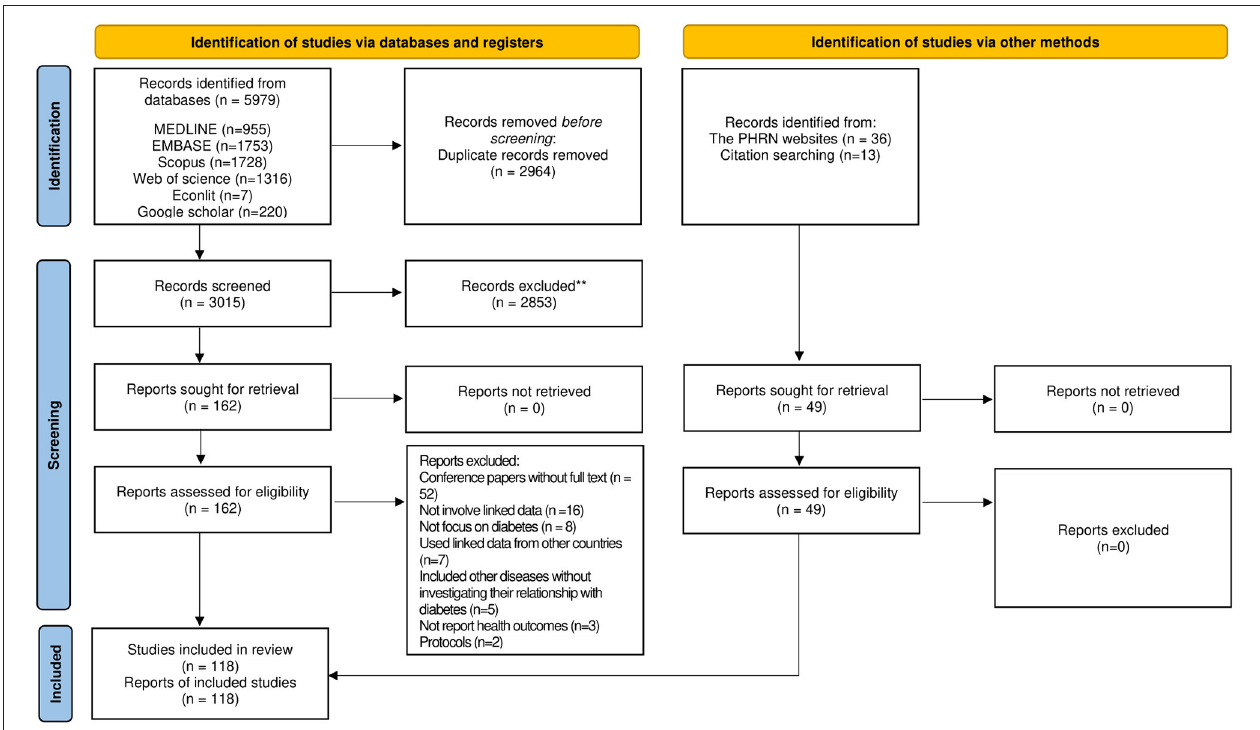
FIGURE 1 | PRISMA 2020 flow diagram for new systematic reviews which included searches of databases, registers and other sources. Figure is adopted from Page et al. (18).